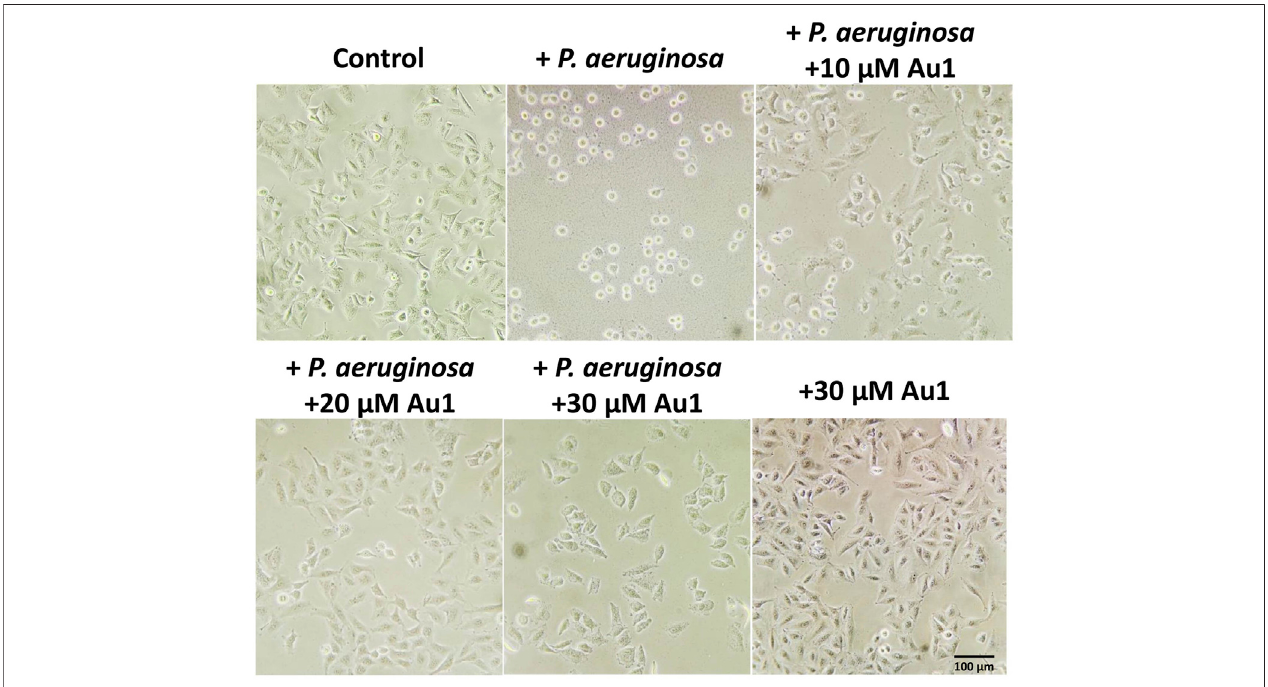
FIGURE 5 | Bacterial and mammalian cell co-culture experiment. Human alveolar basal epithelial A549 cells are incubated with P. aeruginosa in the absence and presence of different concentrations of Au1 compound. Scale bar: 100 μ m.